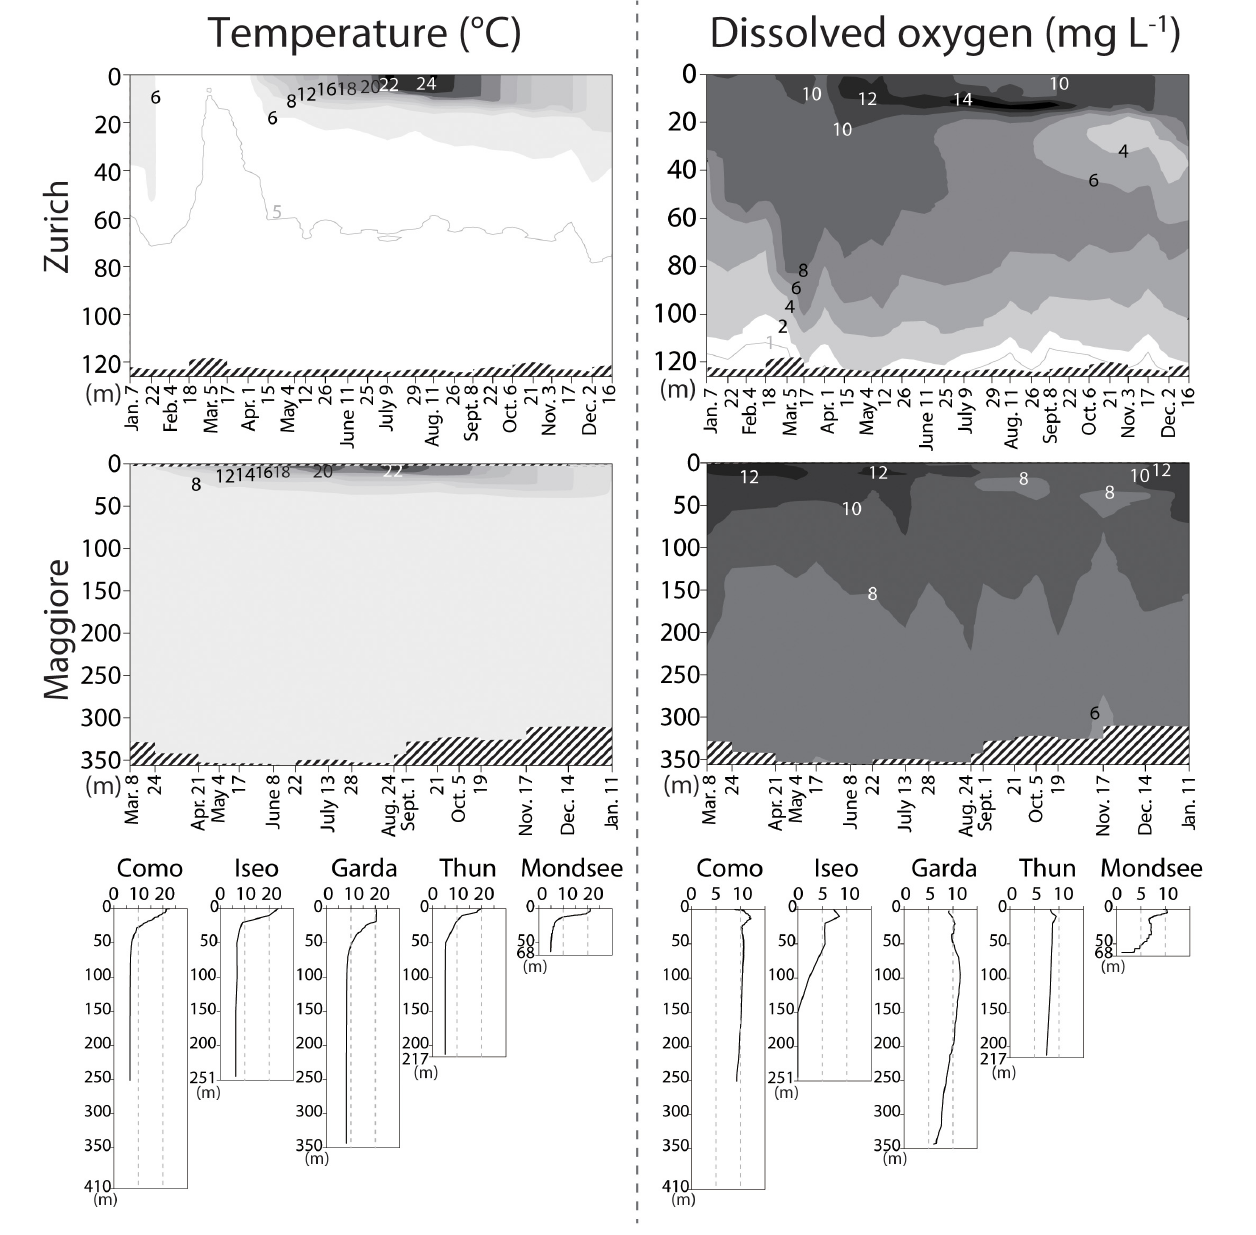
FIGURE 1 | Profiles of the temperature (left panels; ◦ C) and dissolved oxygen (right panels; mg L − 1 ) measured in situ . The vertical axes indicate water depth. For Lake Zurich and Maggiore, the sampling dates are indicated in the horizontal axes, and spatio-temporal measurements are shown by contours. Shaded areas indicate missing